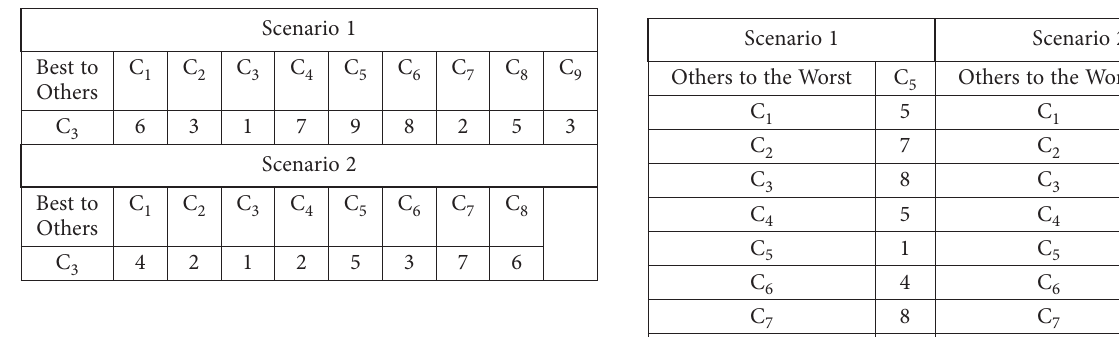
Table 4. The best criterion to the other criteria Table 5. The other criteria to the worst criterion (Scenario